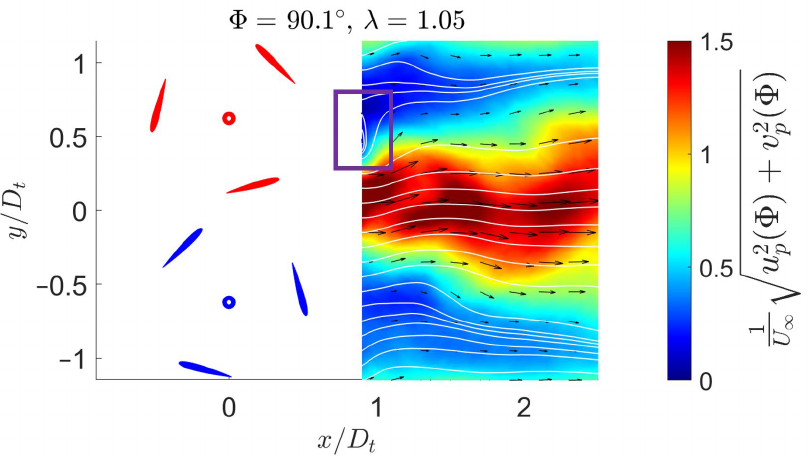
Figure 8. A zoomed in picture of Figure 6h. The re-circulation zone behind turbine T1 is enclosed in the purple solid